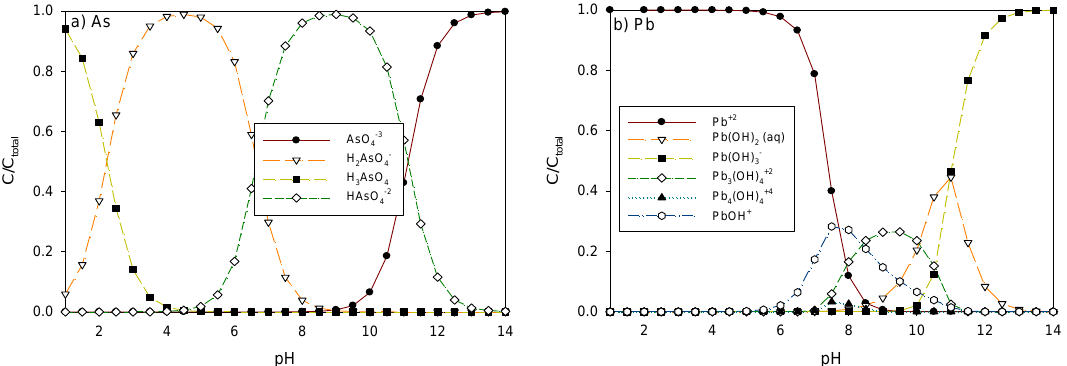
Figure 4. Distribution of ( a ) As and ( b ) Pb compounds as a function of pH predicted by Visual MINTEQ 3.1 software.